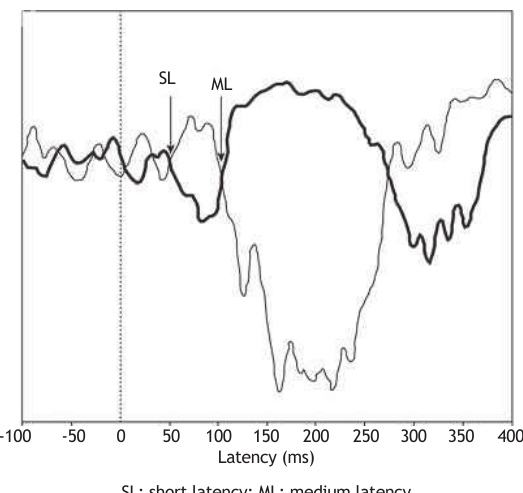
Figure 2 Signals recorded in the right soleus muscle. The thin trace indicates the response from the anode positioned on the right mastoid, and the thick line the response from the anode positioned on the left